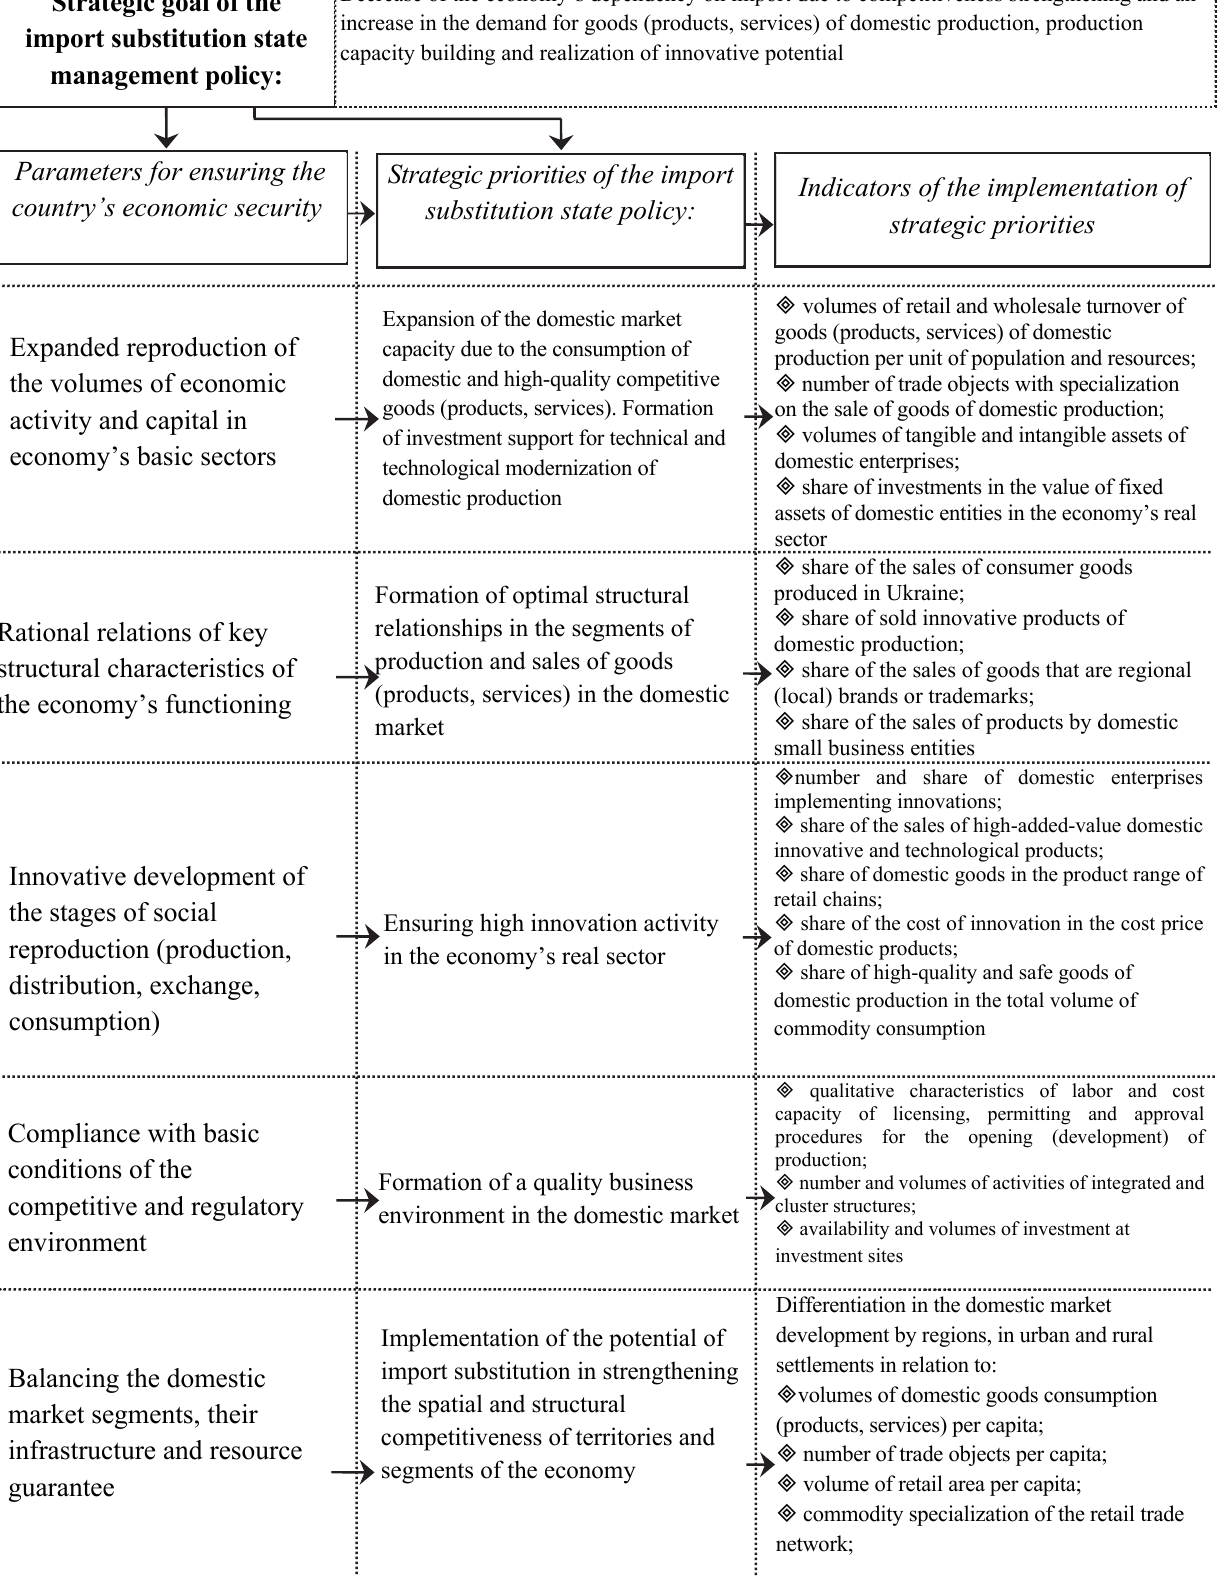
Fig. 3. Characteristics of the strategy of the implementation of import substitution management policy and ensuring the